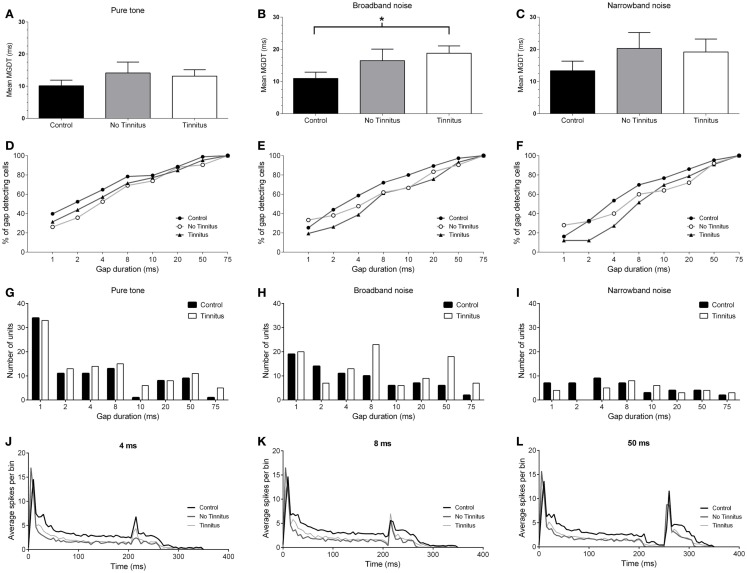
Neural gap detection in the IC. (A) Mean MGDTs in response to pure tone stimuli at CF for control (n = 96), no tinnitus (n = 42), and tinnitus (n = 109) animals. (B) Mean MGDTs in response to BBN for control (n = 76), no tinnitus (n = 42), and tinnitus (n = 103) groups (*P < 0.05). (C) Mean MGDTs in response to NBN for control (n = 43), no tinnitus (n = 25), and tinnitus (n = 33) GPs. (D) The percentage of gap-detecting cells, relative to total cell count in response to pure tone stimuli for control, no tinnitus, and tinnitus GPs. For each gap duration (1, 2, 4, 8, 10, 20, 50, and 75 ms) the percentage of cells able to detect a gap less than or equal to a given duration is shown. (E) The percentage of gap-detecting cells with a BBN carrier. (F) The percentage of gap-detecting cells with an NBN carrier. (G) Distribution of the number of units with MGDTs for each gap duration in response to pure tone stimuli, shown for control and tinnitus GPs. For the purposes of clarity, no tinnitus GPs have been omitted. (H) Distribution of MGDTs in response to BBN stimuli. (I) Distribution of MGDTs in response to NBN stimuli. (J) The averaged population responses of IC neurons in control (black line), no tinnitus (dark gray line), and tinnitus (light gray line) groups for gaps of 4 ms duration, in response to a pure tone carrier. (K) Averaged population responses to gaps of 8 ms duration. (L) Averaged population responses to gaps of 50 ms duration.